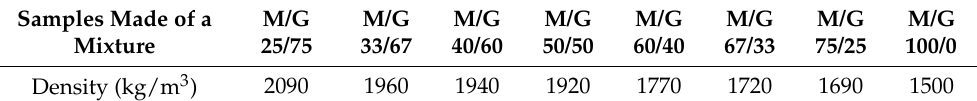
Table 3. The average density of geopolymers with different CRT glass contents.